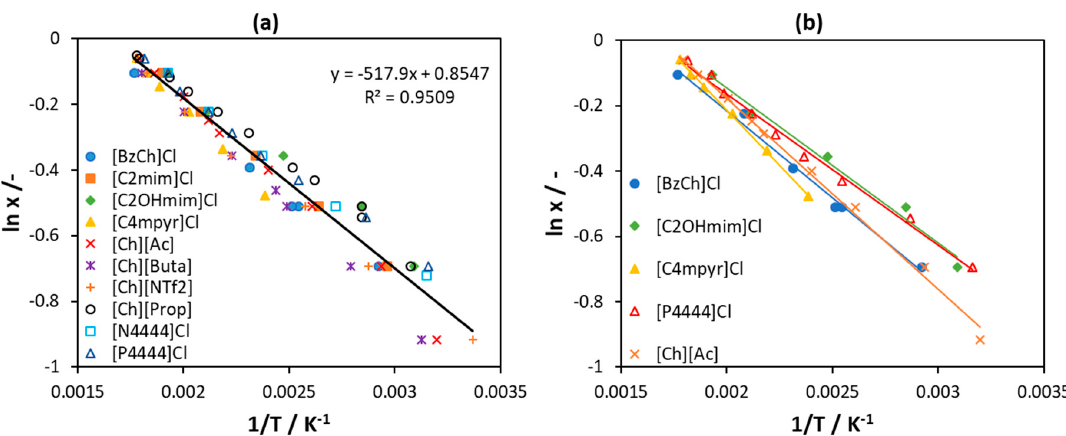
Figure 7. ( a ) Solubility of choline chloride ([Ch]Cl) in several ILs regressed to a linear function. ( b